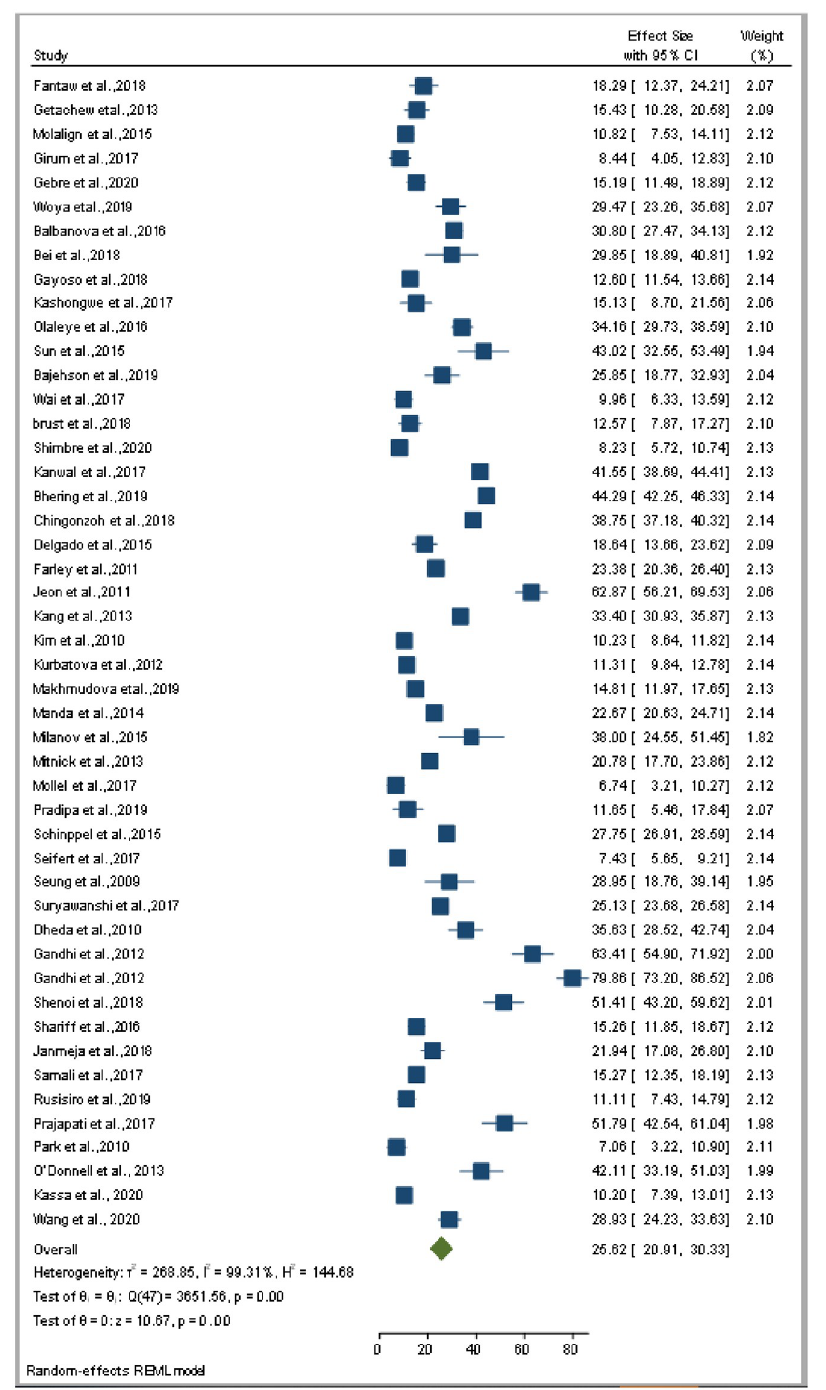
Fig 2. Forest plot for pooled incidence of mortality in patients with drug-resistant tuberculosis.